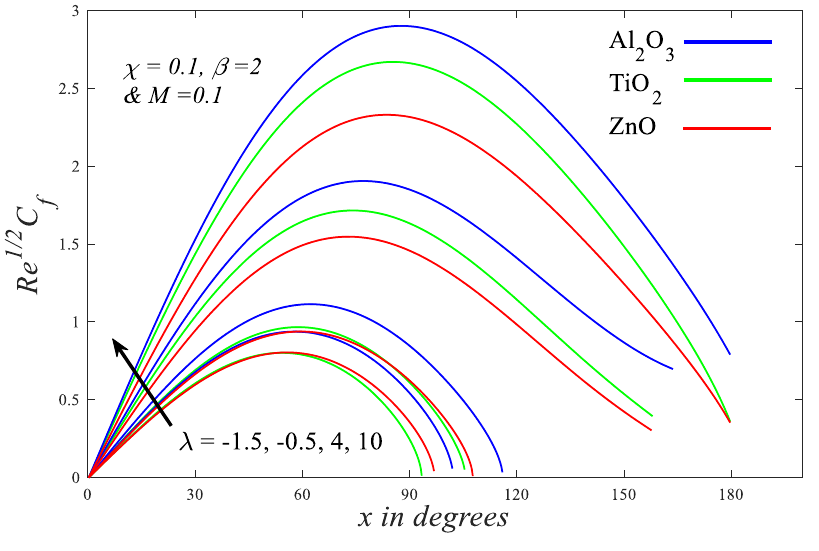
1/2 C  f . on 1/2 Re